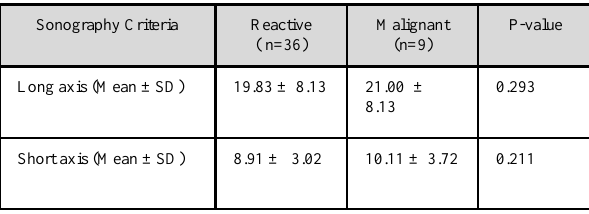
Table 2 B-mode and elastography features of the reactive and metastatic axillary lymph nodes.